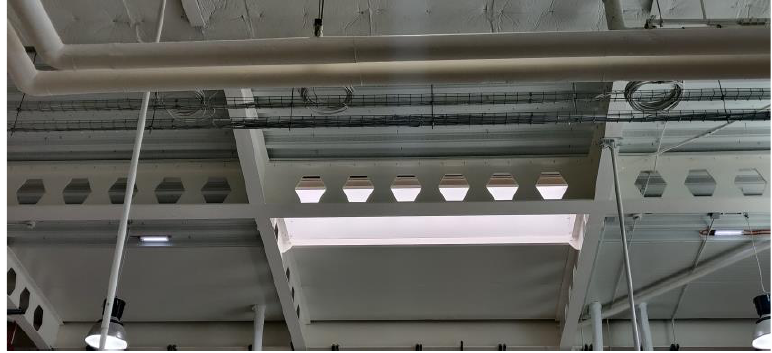
Figure 1. Example of application of perforated elements.